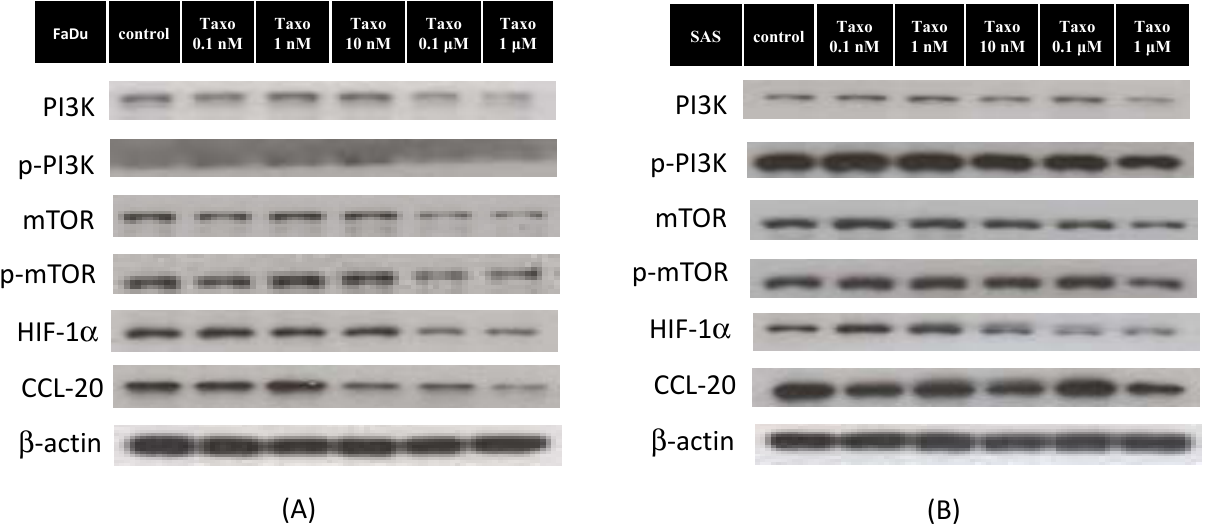
Figure 3. Effect of docetaxel on the mTOR signaling pathway. Cells were treated with docetaxel for 24 h. ( A ) Western blot analysis showed that levels of p-PI3K, PI3K, p-mTOR, mTOR, HIF-1 α , and CCL-20 were reduced in FaDu cells treated with docetaxel in a dose-dependent manner. ( B ) In the SAS cell line, the expression of p-PI3K, PI3K, p-mTOR, mTOR, HIF-1 α , and CCL-20 were obviously decreased in the group treated with a high dose of docetaxel compared to the control group. Densitometric analysis results are shown on the histograms in Figure S2. Data are expressed as the mean ± SEM of three independent